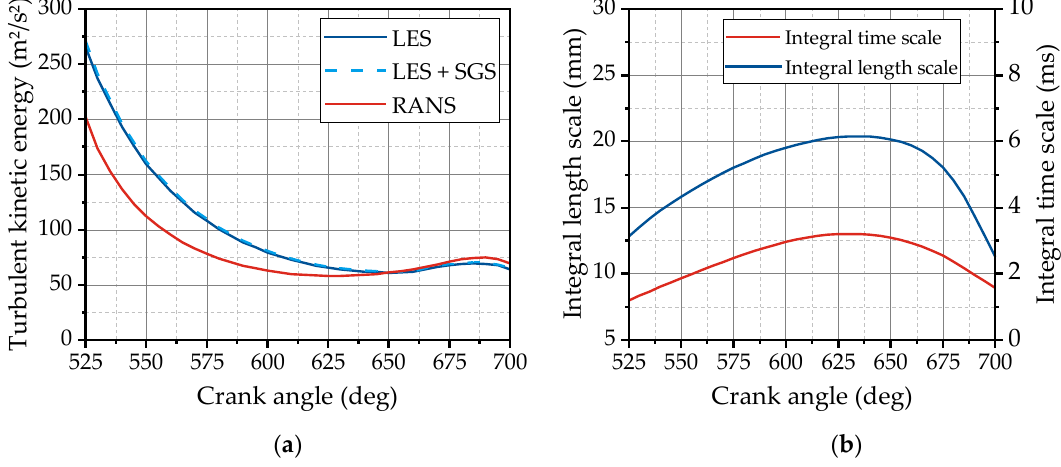
Figure 7. ( a ) Turbulent kinetic energy during compression for RANS and LES. ( b ) Integral length and time scale derived from the RANS solution during compression.